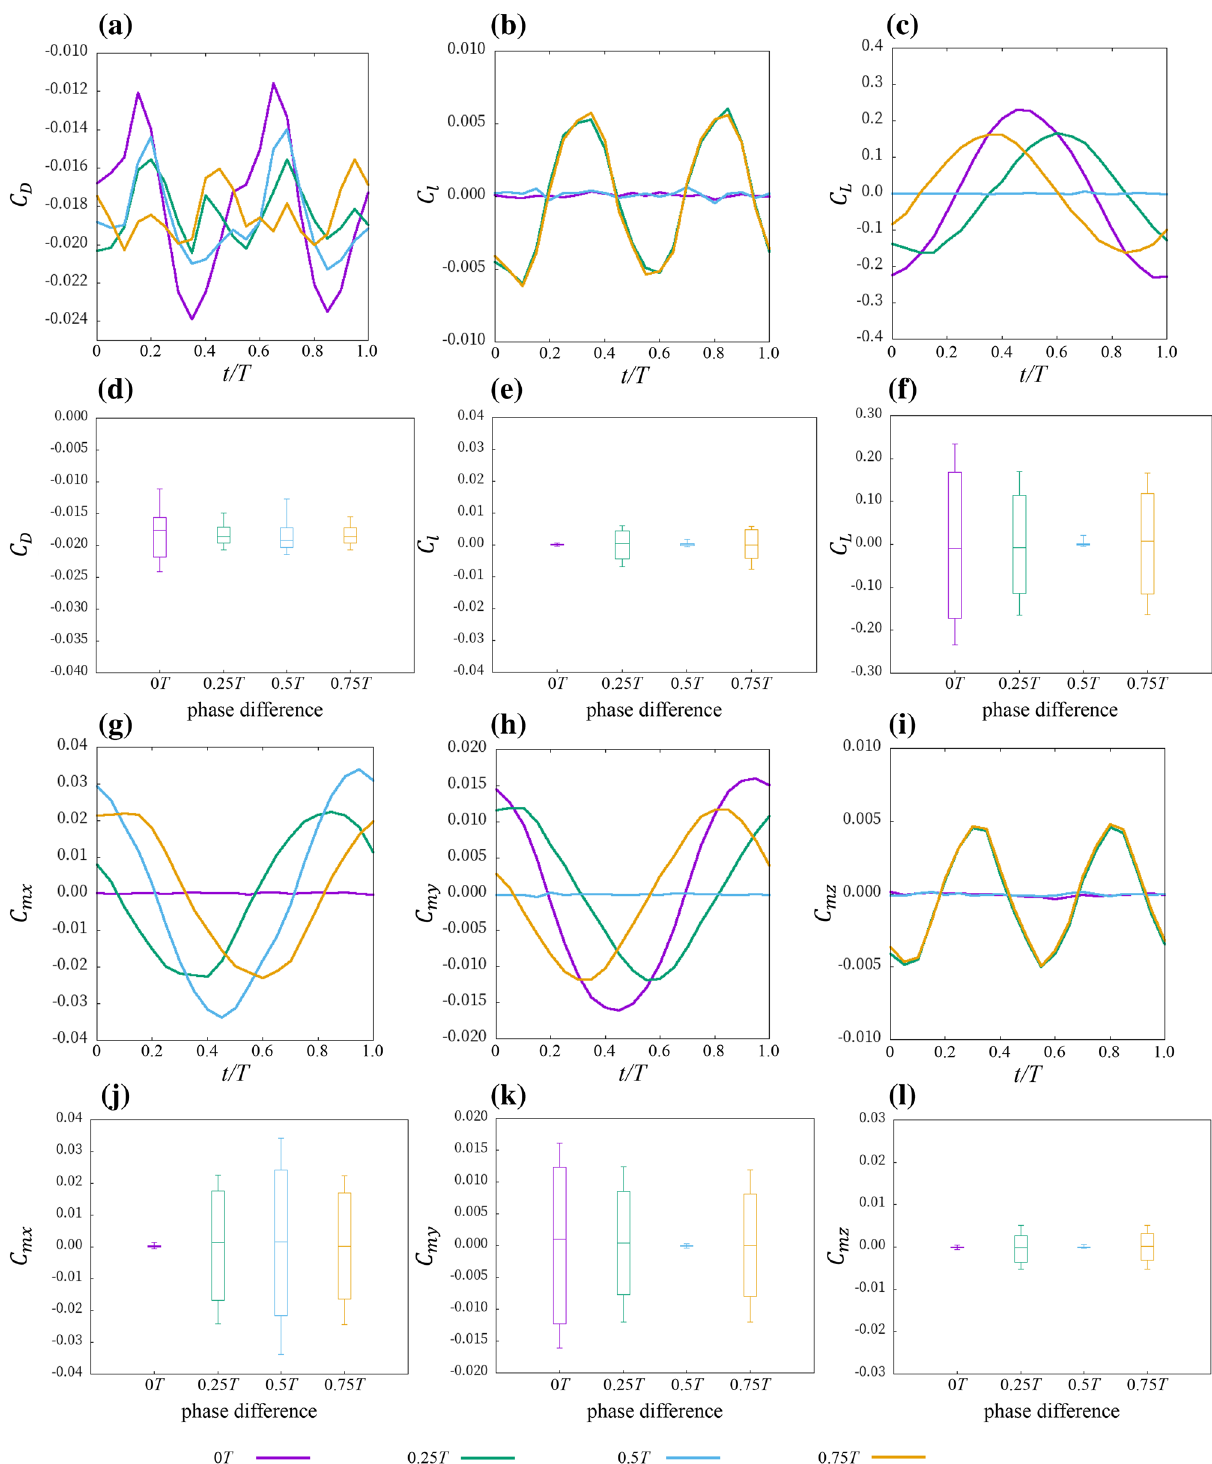
Figure 4. Instantaneous forces during one pectoral fin beat cycle of D. matsubarai forward swimming and Box-plot graph. ( a , d ) Drag coefficient, ( b , e ) lateral force coefficient, ( c , f ) lift coefficient, ( g , j ) moment coefficient around the x -axis, ( h , k ) moment coefficient around the y -axis, and ( i , l ) moment coefficient around the z